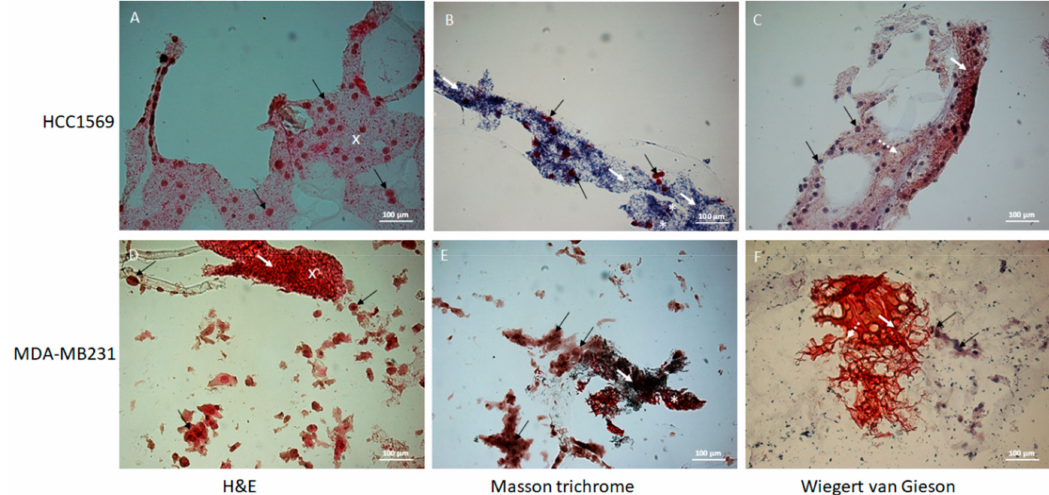
Figure 10. Histological images acquired using inverted microscopy of the cells MDA-MB231 and HCC1569 cultured in the 3D sca ff old for 7 days. Images acquired using inverted microscopy of the cell MDA-MB231 cultured in the 3D sca ff old (20 × magnification) and stained with H&E, Masson trichrome and Wiegert Van Gieson methods. The white arrows indicate collagen stained by Masson trichrome method, black arrows cells, dotted white arrows the connective stained with Wiegert Van Gieson method, white cross the extracellular matrix stained by H&E method and the white stars the extracellular matrix stained in red by Masson trichrome stain. More samples were analyzed at each analyzed